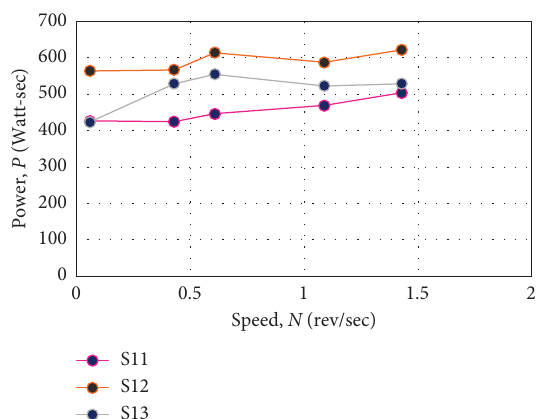
Figure 8: Power consumption for M25 grade concrete.